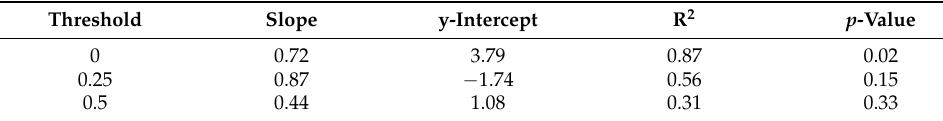
Figure 8. Comparison of 30 m lidar-derived VIs and LANDFIRE/SRTM-derived VIs . VI for each handline (marker shape) is plotted 3 times, once per threshold (marker color). Dashed line indicates a slope of 1. Dashed black line indicates a slope of 1. Table 3. Summary statistics for linear regressions in Figure 8.